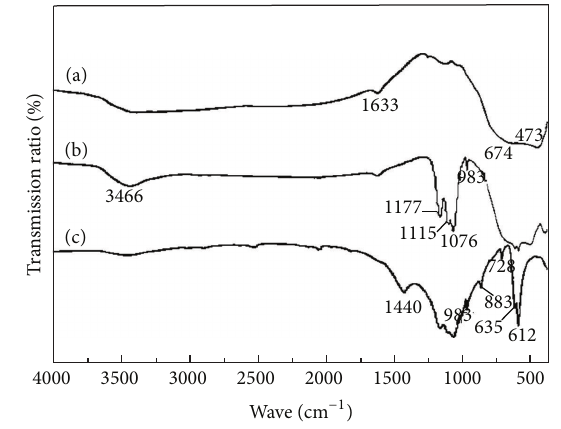
Figure 6: IR spectrum of samples: (a) the IR spectrogram of TiO 2 ; (b) the IR spectrogram of B/TCP; and (c) the IR spectrogram of